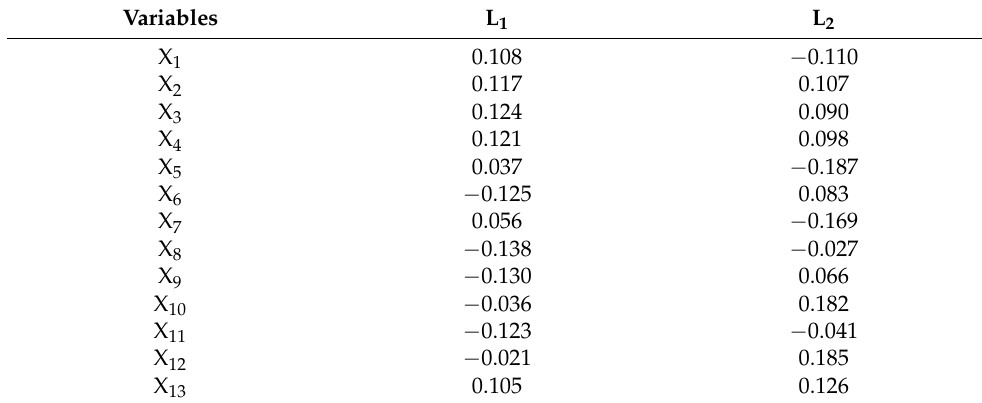
Table 4. Eigenvector